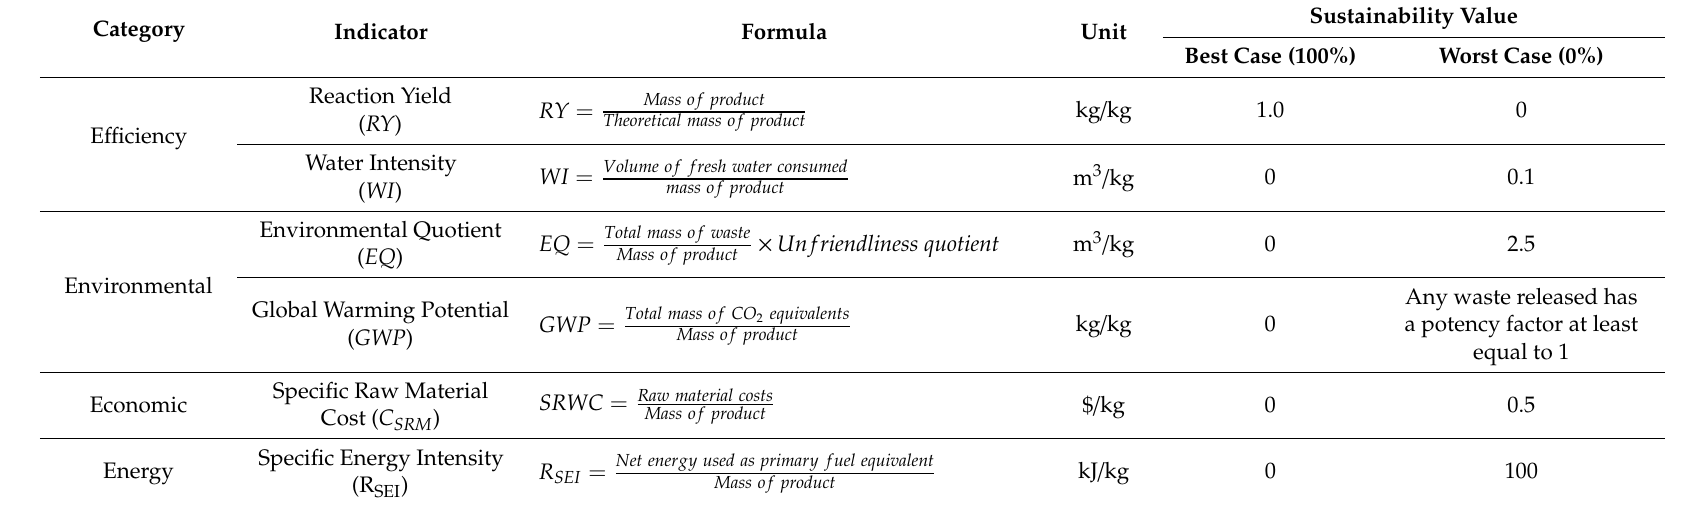
Table A2. Definitions and reference values for selected GREENSCOPE (Gauging Reaction E ff ectiveness for the ENvironmental Sustainability of Chemistries with a multi-Objective Process Evaluator)